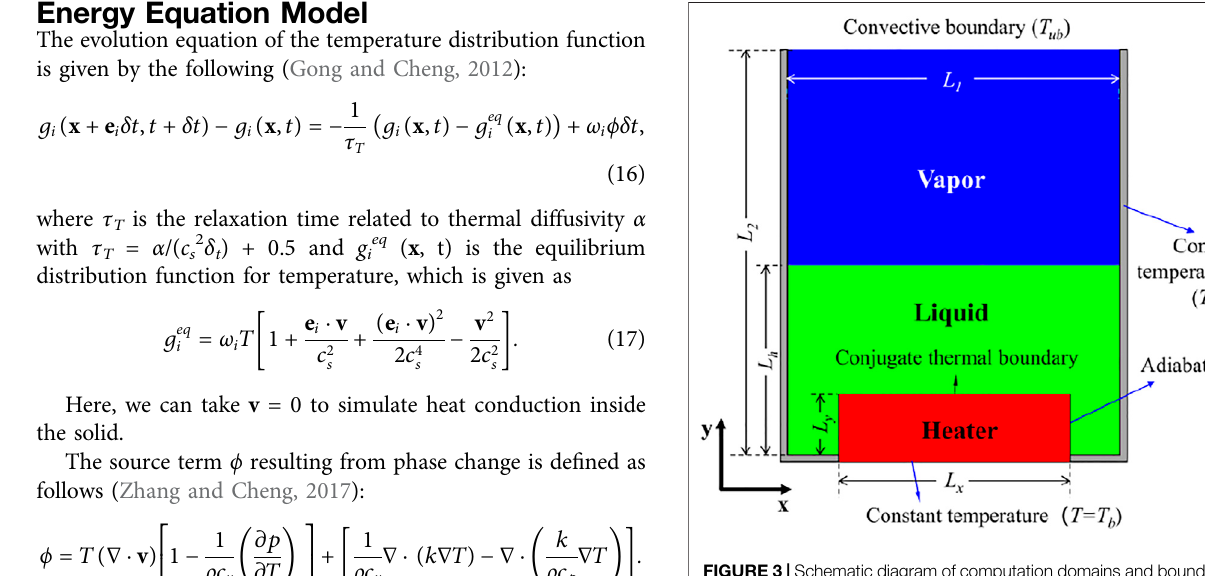
FIGURE 3 | Schematic diagram of computation domains and boundary